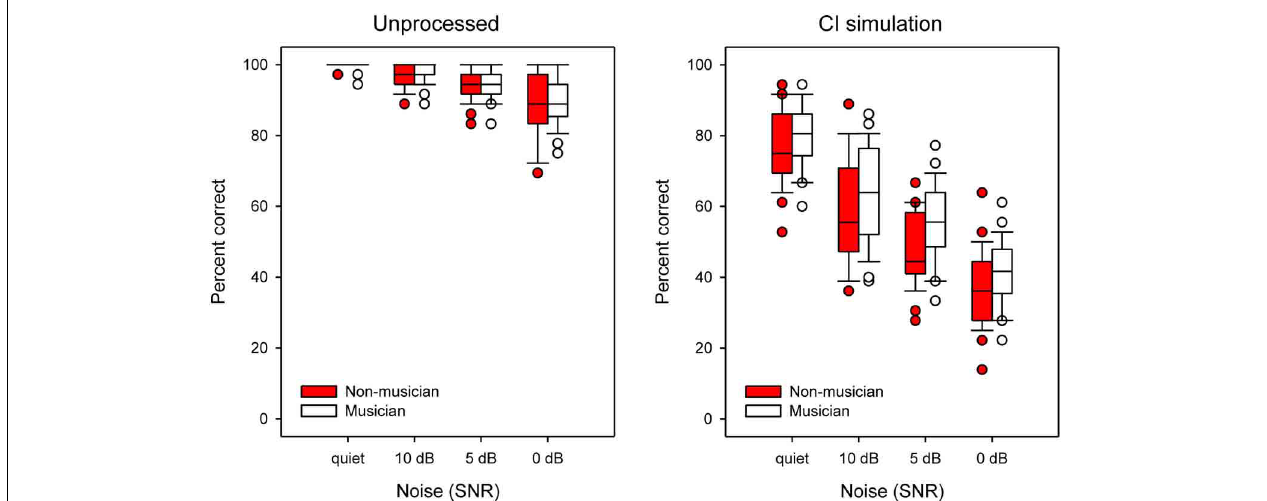
FIGURE 3 | Boxplots of word identification scores for musicians and non-musicians shown as a function of SNR. The left and right panels show data with unprocessed stimuli or with the CI simulation, respectively. The error bars show the 10 and 90th percentiles and the circles show outliers.